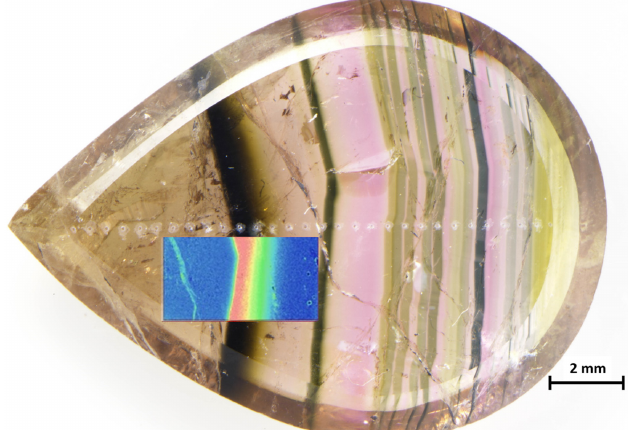
Figure 21. A pear-shaped step-cut gem quality tourmaline stone from Anjanabonoina, Madagascar. An area was analyzed by the Raman mapping technique (blue rectangle; color scale shown in Figure 23). Laser ablation (LA-ICP-MS) craters are visible as dots across the table of the sample. Chemical data obtained by LA-ICP-MS classify the thickest black band as elbaite, with the remaining sample classified as liddicoatite. Sample courtesy of Barbara L. Dutrow.